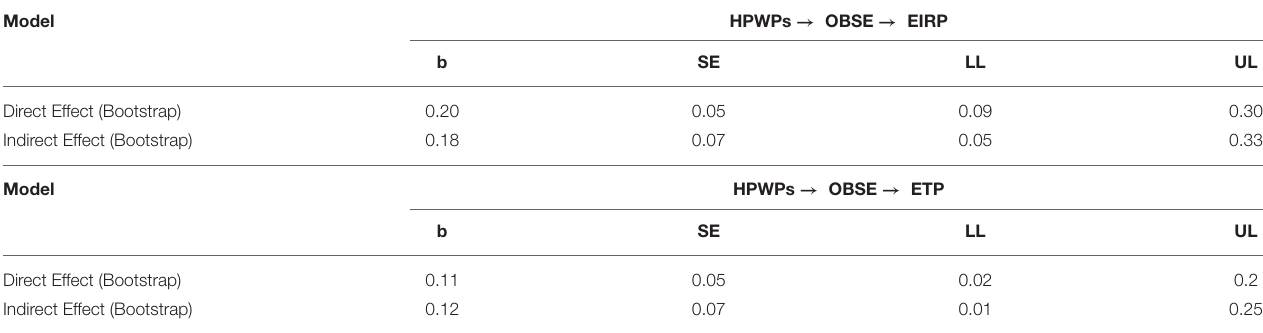
TABLE 2 | Direct and indirect effect results (both dependent variables).